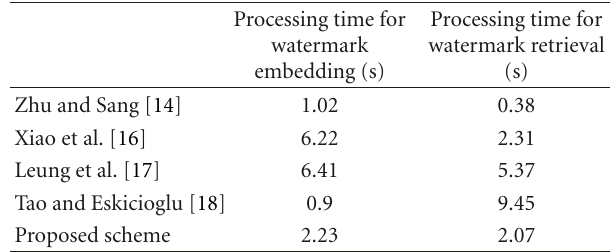
Table 11: The processing time for watermark embedding and